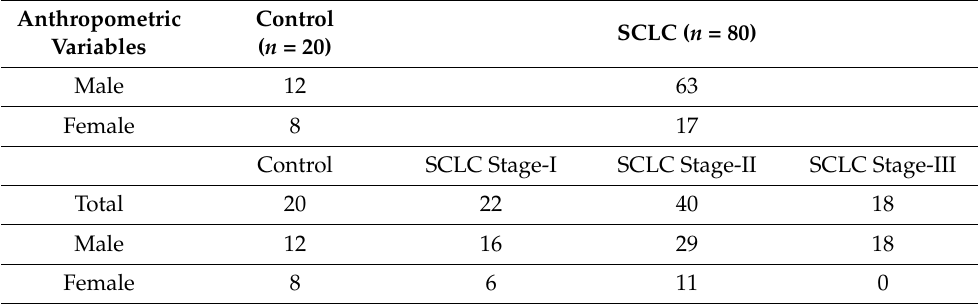
Table 1. Anthropometric details of the study